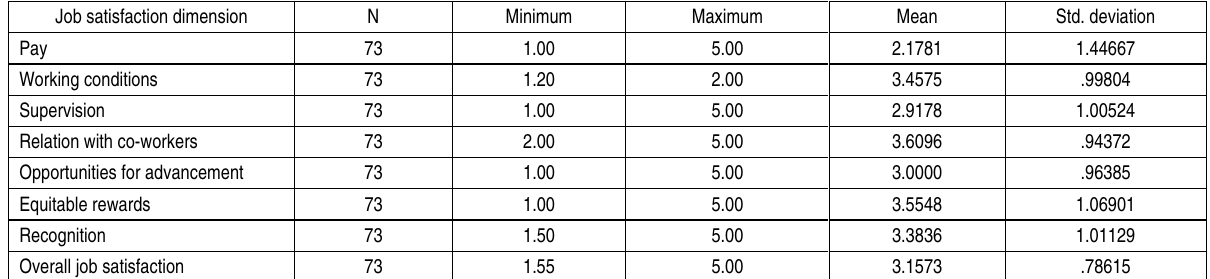
Table 3. Mean, std. deviation, minimum and maximum scores for the sub-dimensions of job satisfaction